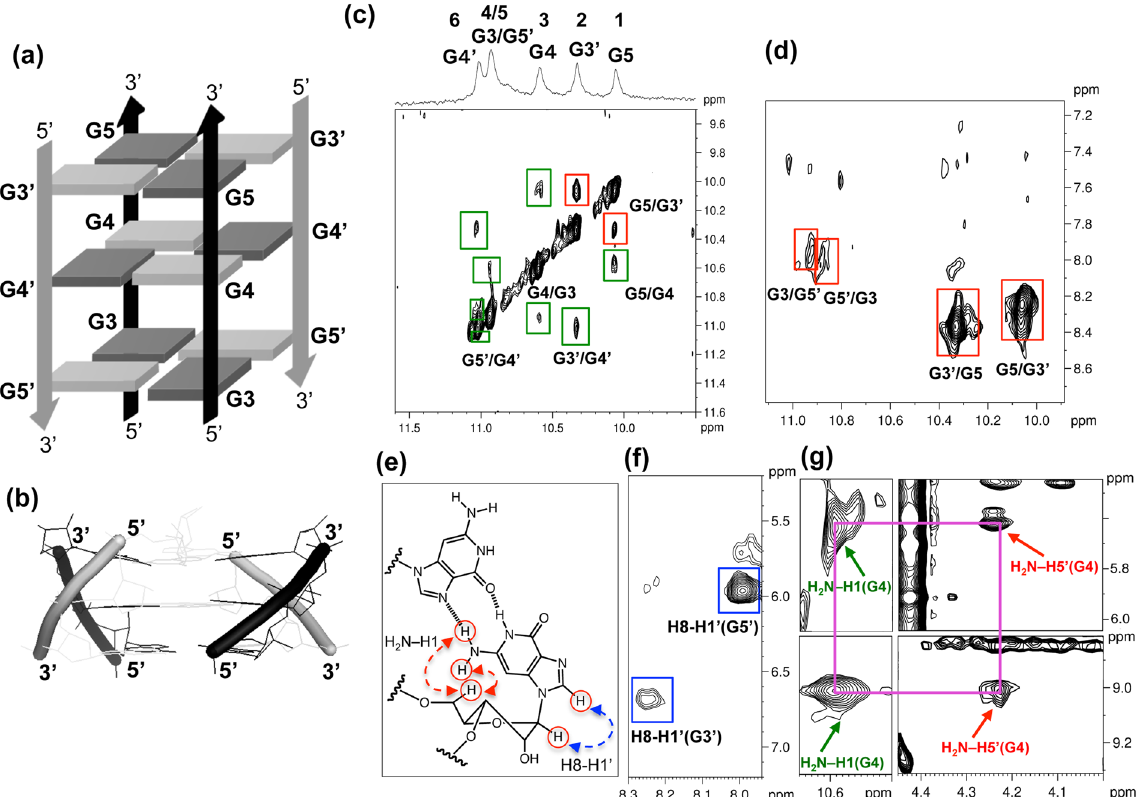
Figure 3. ( a ) Schematic structure of ORN-2, where syn and anti residues are in grey and black, respectively. For clarity, the two unequivalent strands with the contrary orientation are labeled 5 ′ -U1-A2-G3-G4-G5-U6-3 ′ (black) and 5 ′ -U1 ′ -A2 ′ -G3 ′ -G4 ′ -G5 ′ -U6 ′ -3 ′ (grey), U and A residues have been omitted. ( b ) Side view of the antiparallel G-quadruplex structure. ( c ) H1-H1 region and ( d ) H1-H8 region of 2D-NOESY spectra of ORN-2 in the presence of 100 mM KCl and 10 mM potassium phosphate buffer; imino peaks were labeled with correspond numbers. Intratetrad and sequential connectivity were represented by red and green boxes, respectively. ( e ) Schematic representation of syn-glycosidic conformation of rG with arrows indicating the H8-H1 ′ and amino protons-H5 ′ NOEs. (f) H8-H1 ′ region of 2D-NOESY spectrum of ORN-2. Intraresidue H8-H1 ′ cross peaks of G3 ′ and G5 ′ indicate that the two rG residues were syn conformation. ( g ) NOEs of G4 are labeled with purple frame. The red allows indicated NOE peaks of non-hydrogen-bonded-and hydrogen- bonded-amino protons of G4 with itself H5 ′ (upper and lower). The green allows indicated NOE peaks of non- hydrogen-bonded- and hydrogen-bonded-amino protons of G4 with itself H1 (upper and